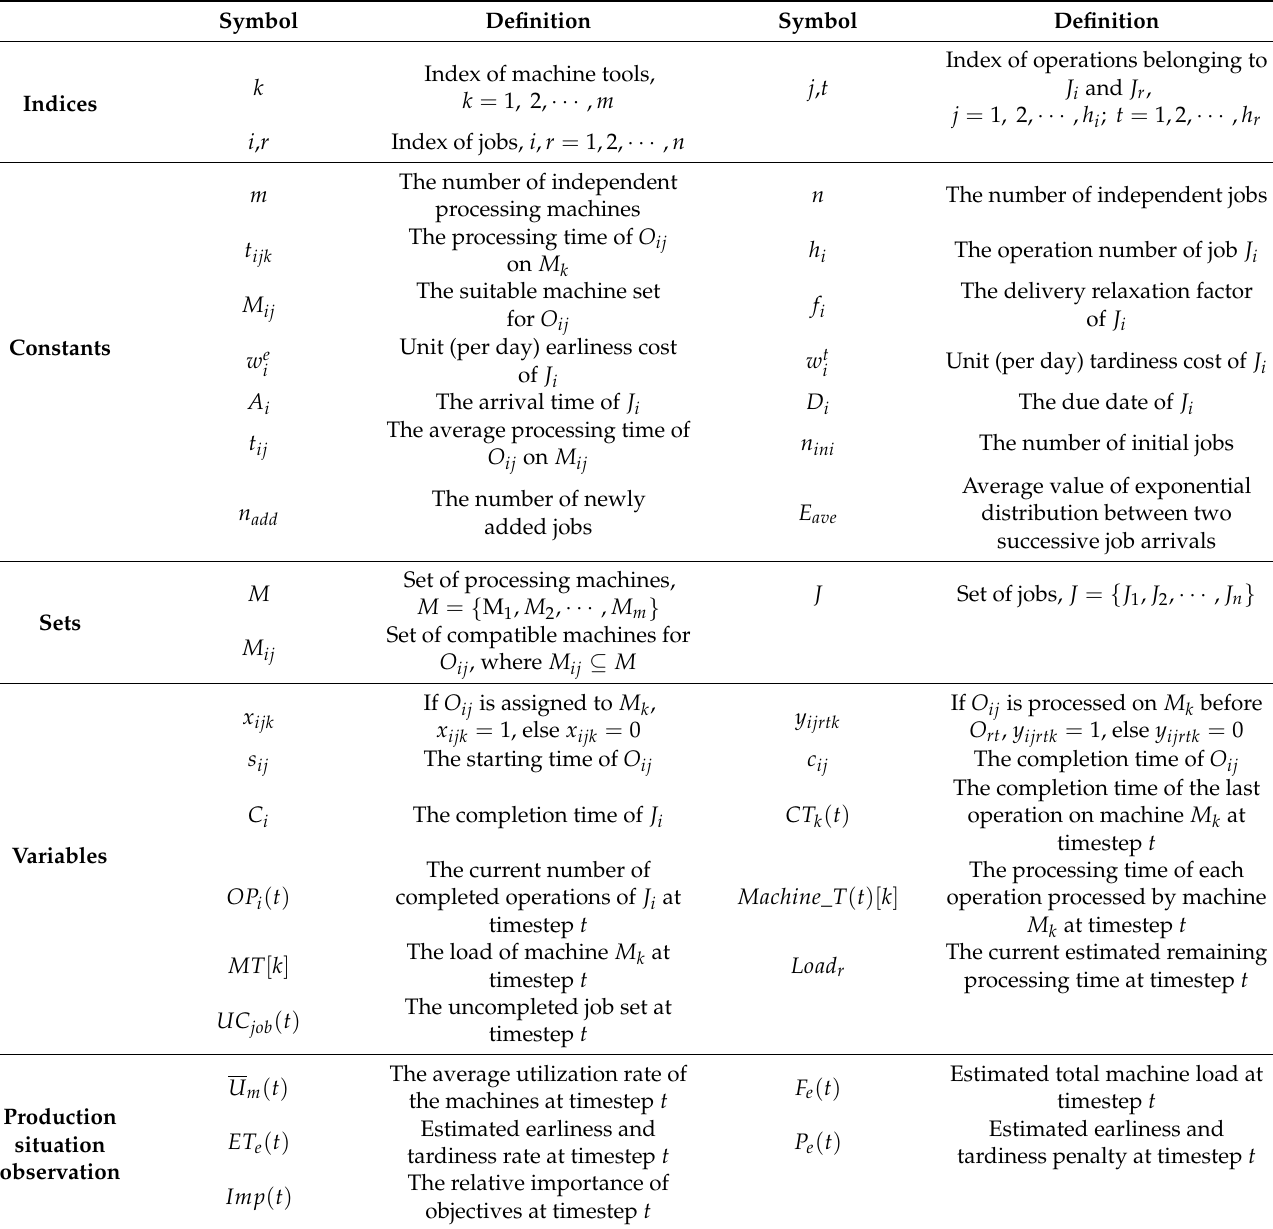
Table 2. Related mathematical notations and their